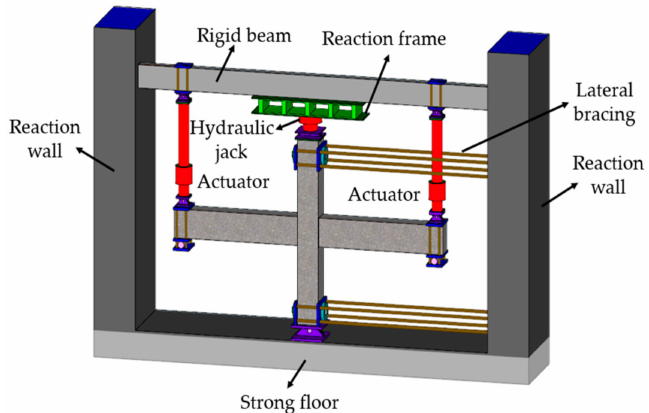
Figure 3. Schematic diagram of joint loading device.